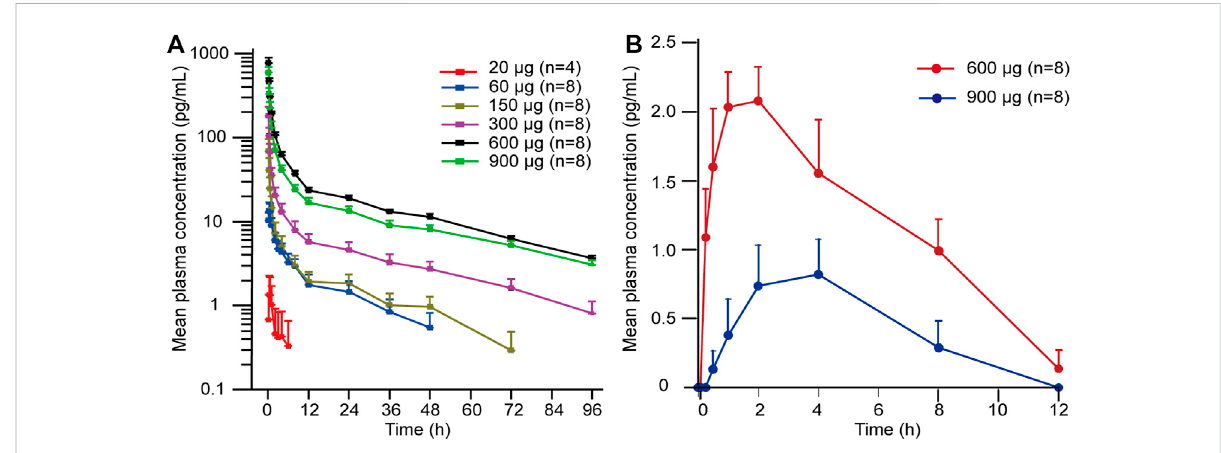
FIGURE 2 Mean plasma concentration-time curves of 101BHG-D01 and M6 after single inhaled doses of 101BHG-D01 inhalation aerosol in healthy Chinese subjects. (A) 101BHG-D01 (semi-logarithmic scale). (B) M6 (linear scale). Bars represent SDs. n, number of